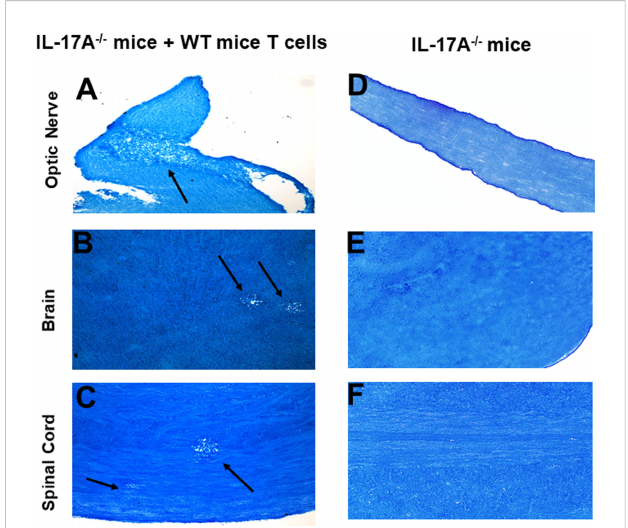
FIGURE 4 Adoptive transfer of WT T cells to IL-17A -/- mice. Naive T cells were isolated from 5 WT mice. Magnetically isolated cells were transferred by intraperitoneal injection into 5 recipient IL-17A -/- mice. Two weeks post-adoptive transfer, recipient mice (A, B, C) and control IL-17A -/- mice without T cells transfer (D, E, F) were infected ocularly with 2 X10 5 pfu/eye of HSV-IL-2 virus. Representative optic nerves (A, D) , brain (B, E) , and spinal cord (C, F) on day 14 PI from infected mice are shown. Arrows indicate areas of demyelination. x10 objective lens was used (100x mag.).